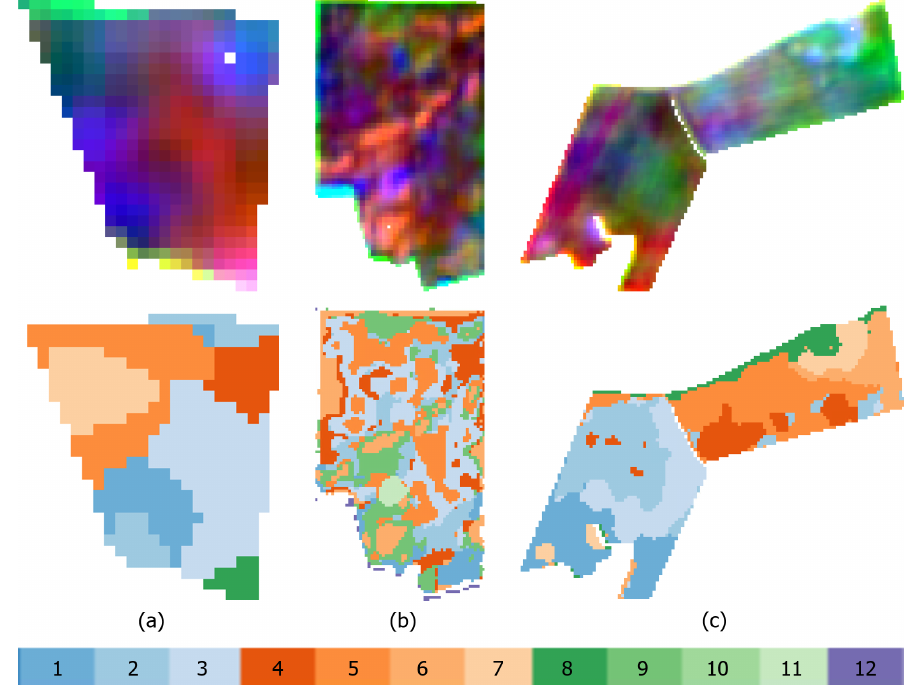
Figure 4. Feature RGB, first row, and color coded soil zoning, second row, results on the chosen fields. ( a ) Hasler, Switzerland; ( b ) Kreuzhuegel, Germany; ( c ) Quellenacker,